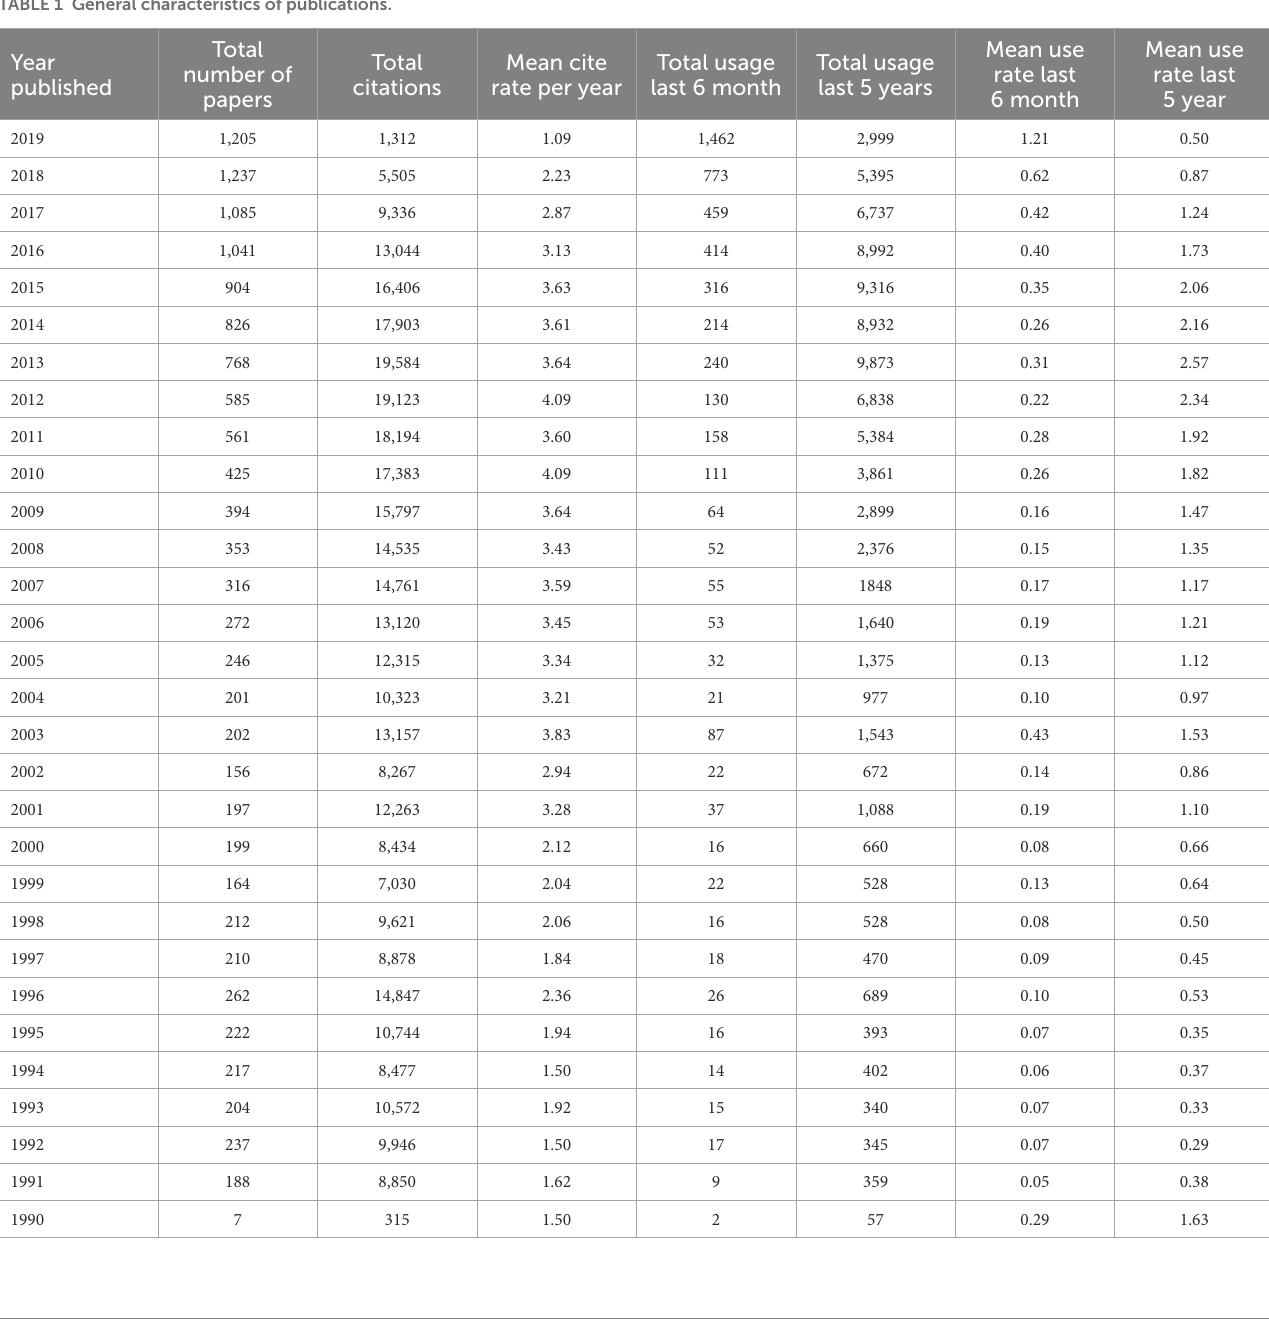
TABLE 1 General characteristics of publications.